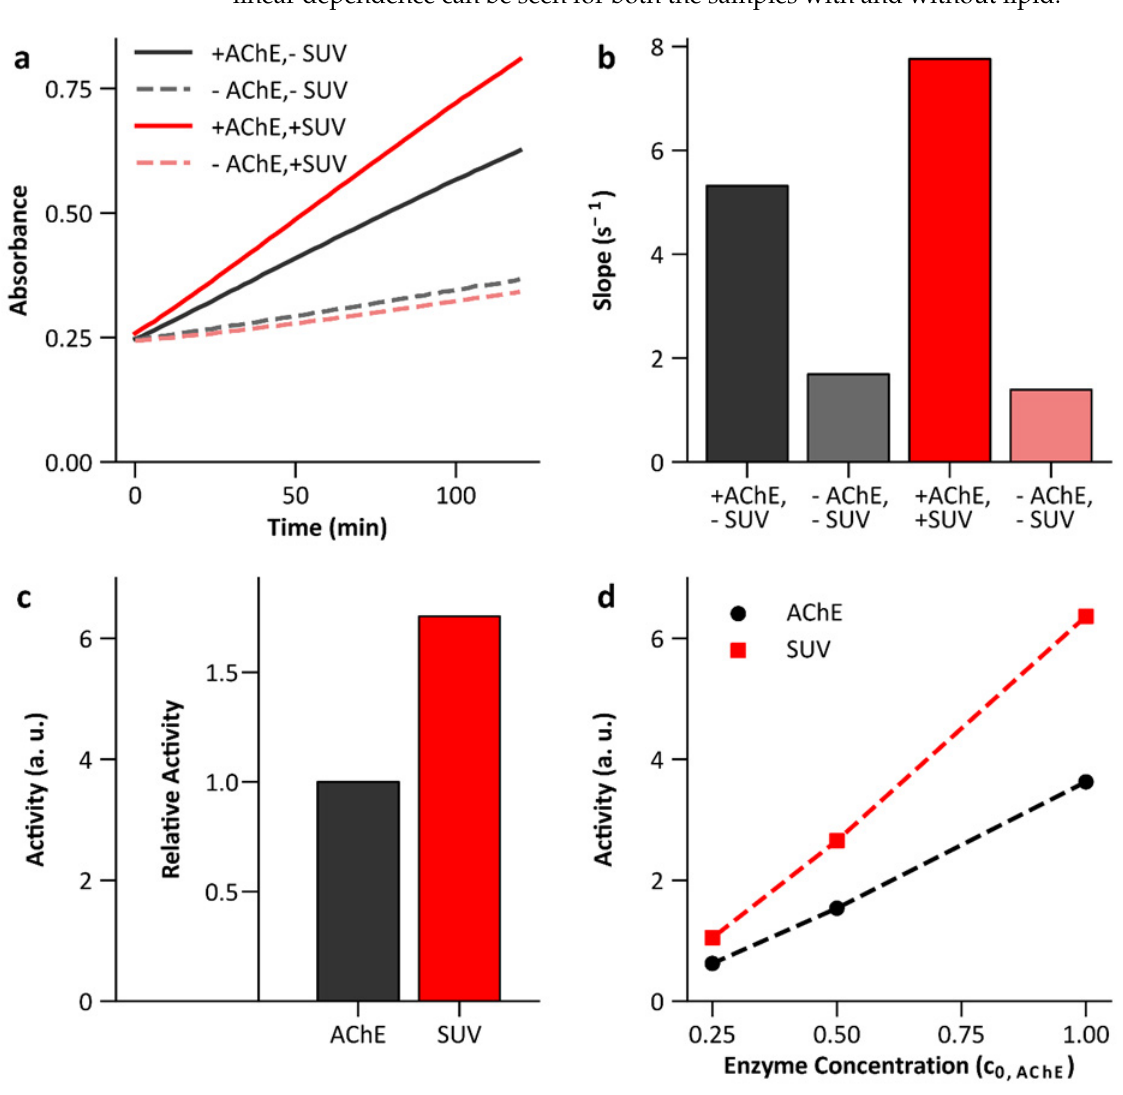
Figure 9. Enzyme activity of AChE in presence and absence of lipid membranes. ( a ) Absorbance measurement at room temperature using the Ellman assay. ( b ) Slope of the absorption kinetics determined by a linear fit. ( c ) The activity results from the difference of the slopes of the samples with and without enzymes. ( d ) Activity in dependence of the enzyme concentration with and without SUV (c 0,AChE = 0.2 nm).